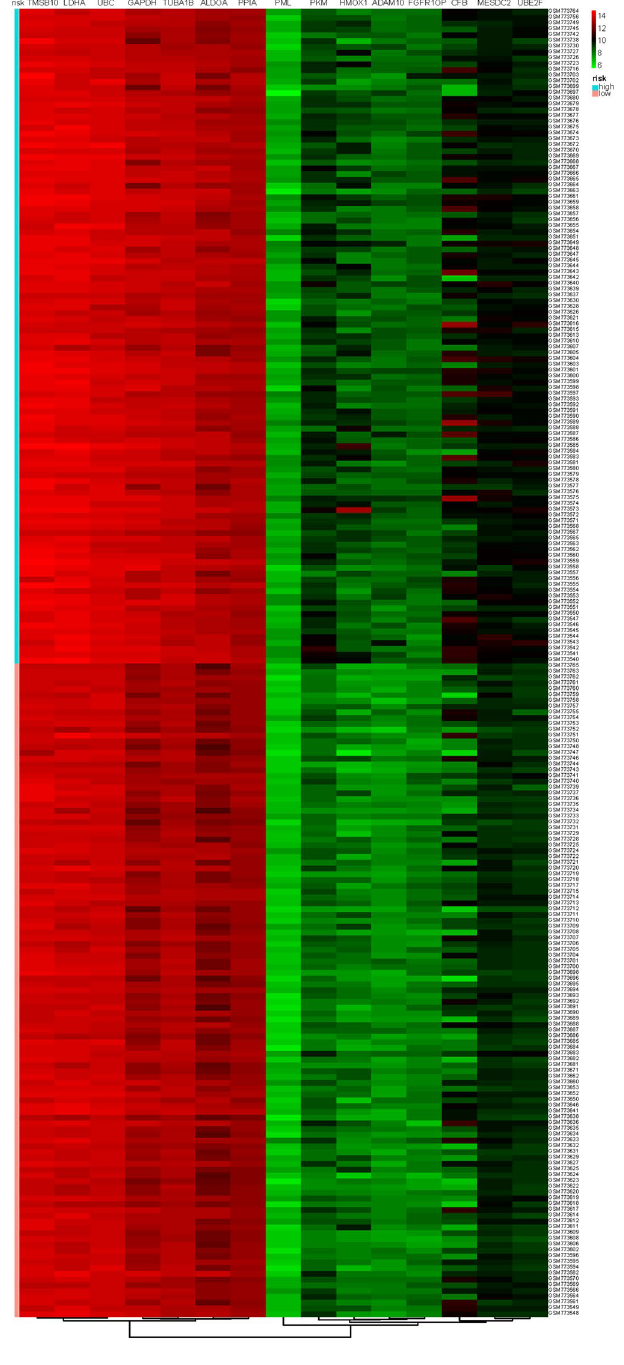
Figure 3. Heatmap of the fifteen-mRNA signature and risk scores in the training set(n = 226, GSE31210). The “pheatmap” package of R software (version 3.5.1) was used to generate the